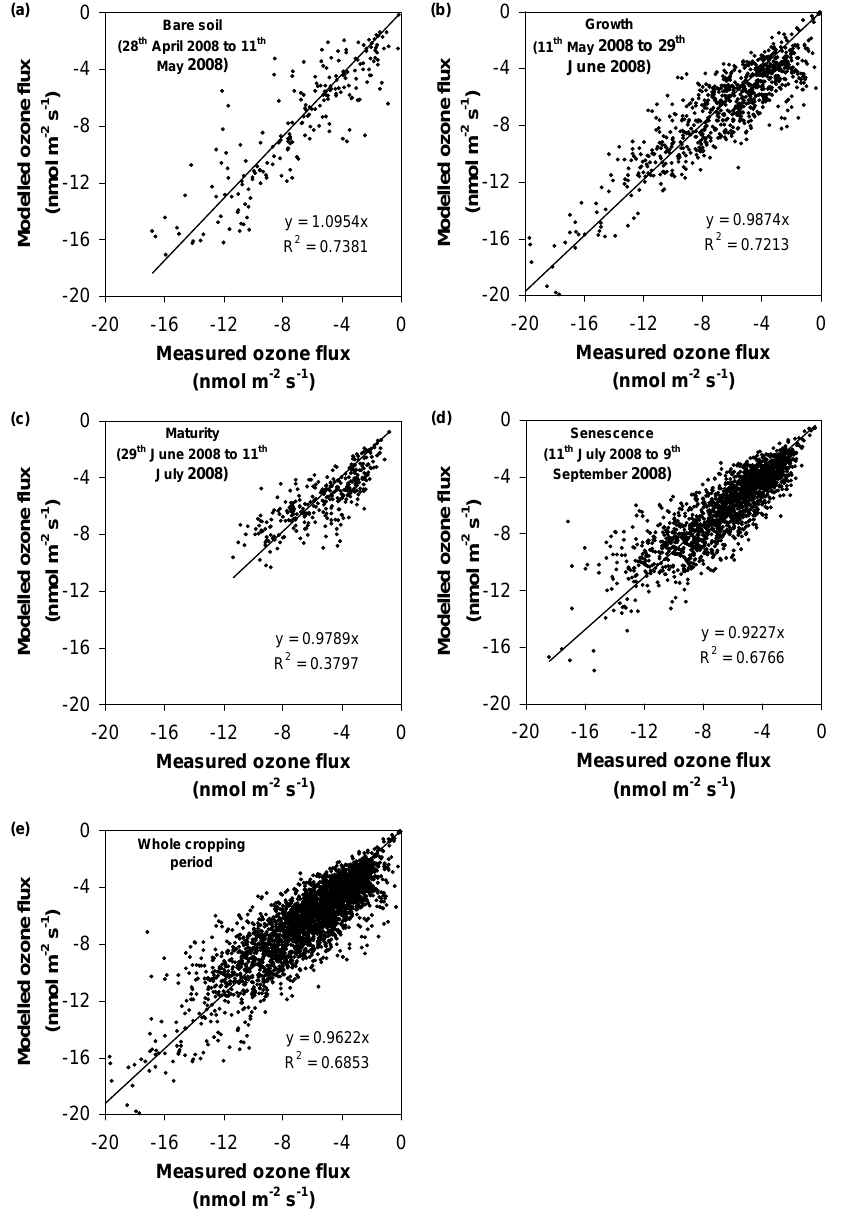
Figure 4: Comparison between modelled and measured ozone fluxes for the Grignon site 31 Fig. 4. Comparison between modelled and measured ozone fluxes for the Grignon site during (a) bare soil period, (b) growth, (c) maturity, during (a) bare soil period, (b) growth, (c) maturity, (d) senescence, and (e) whole cropping 32 (d) senescence, and (e) whole cropping period. Only data for u ∗ > 0.1ms − 1 are period. Only data for u * > 0.1 m s -1 are represented. 33